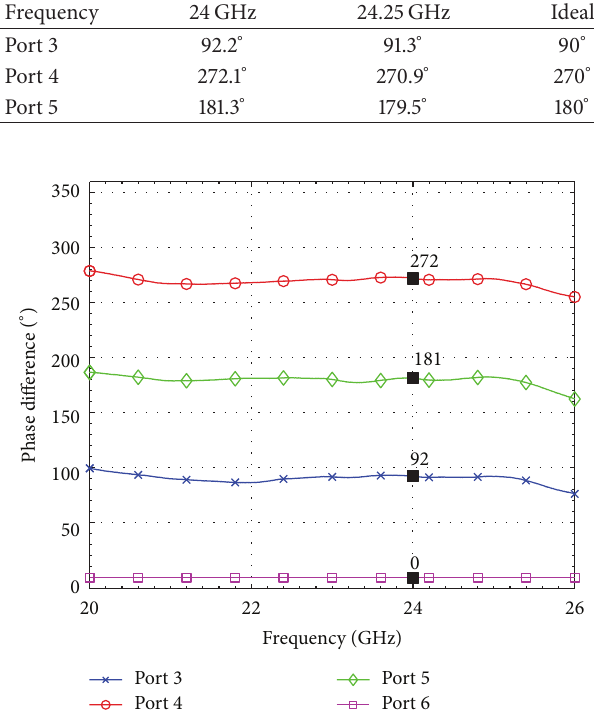
Figure 15: Measured normalized phase difference at the output ports of the Six-port network (reference port 6 is set to 0 ∘